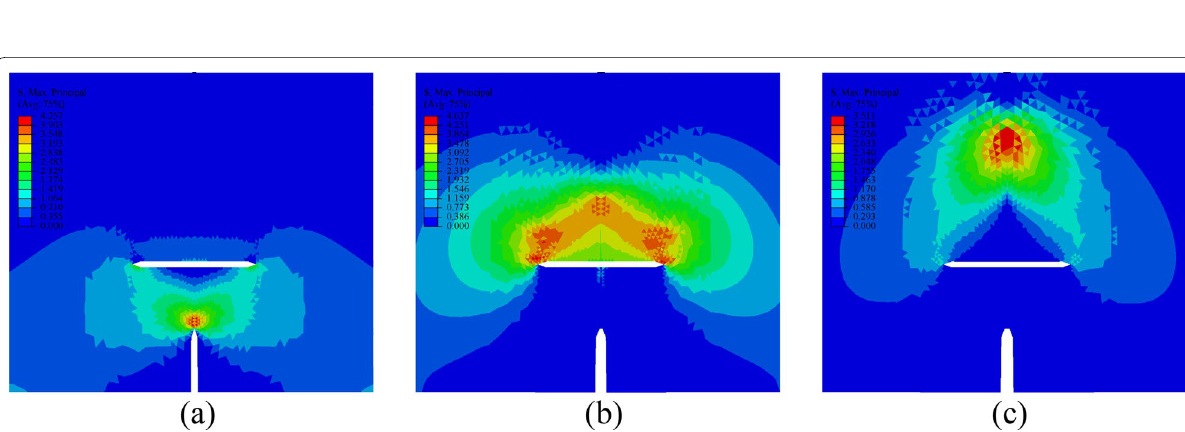
Fig. 12 Evolution of maximum principal stress distribution of TPB‑A90‑T2 during the fracture processes: ( a ) crack initiation, ( b ) crack intersection, and ( c ) instability stage